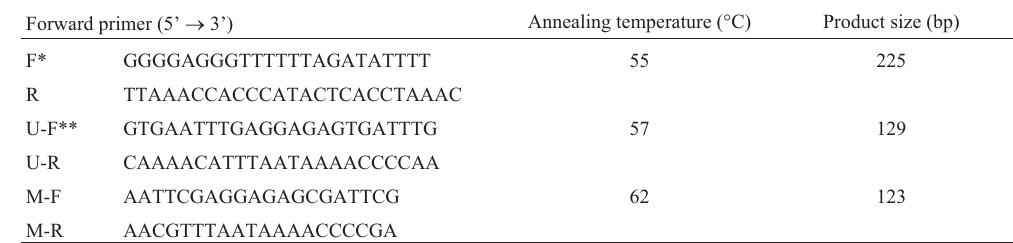
Table 1 - MSP and BSP primer sets and annealing